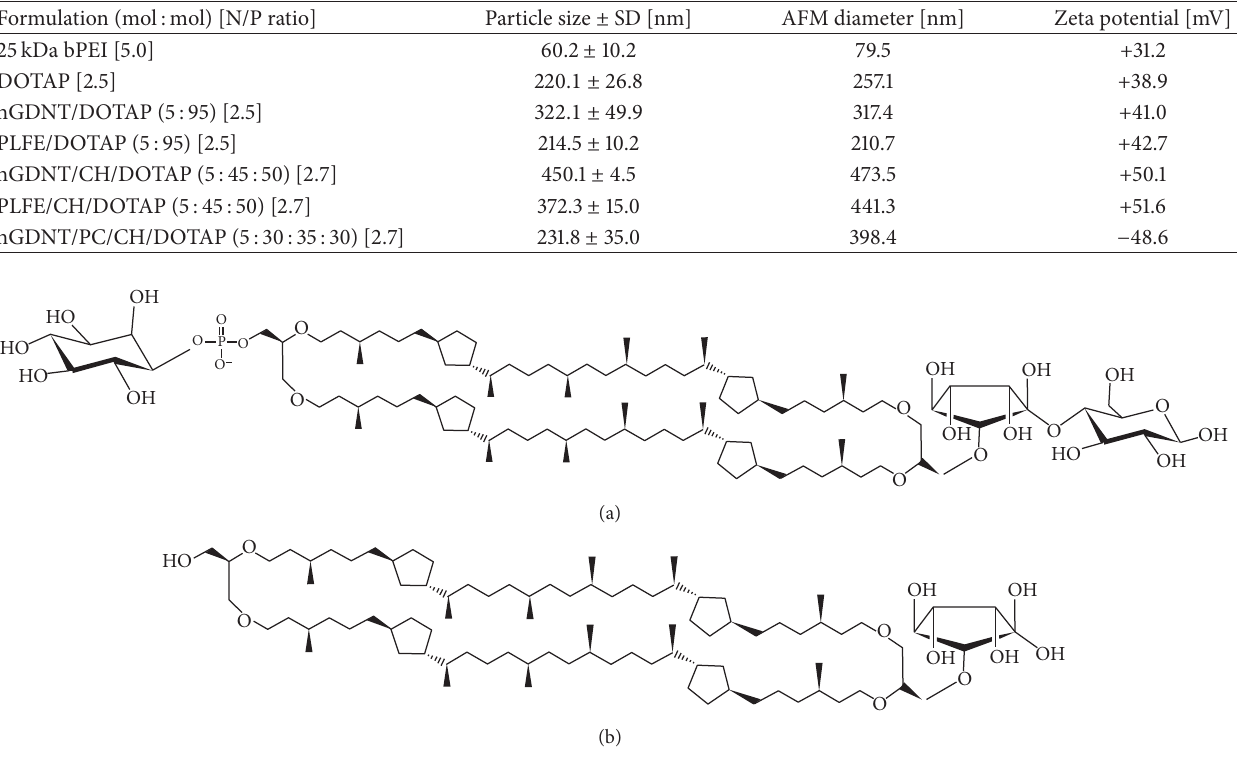
Figure 1: Structures of nonhydrolysed and hydrolysed fractions of tetraether lipids derived from Sulfolobus acidocaldarius . (a) PLFE and (b)